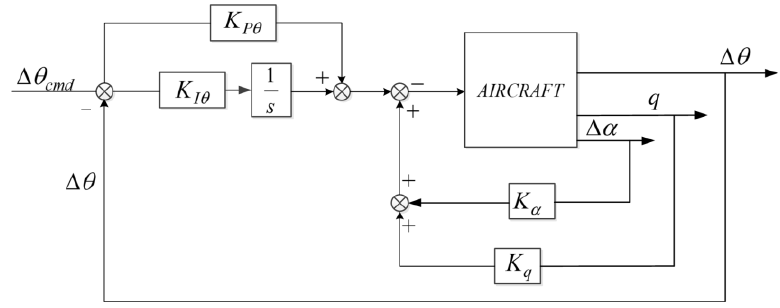
Figure 9. Longitudinal control law of the test model.